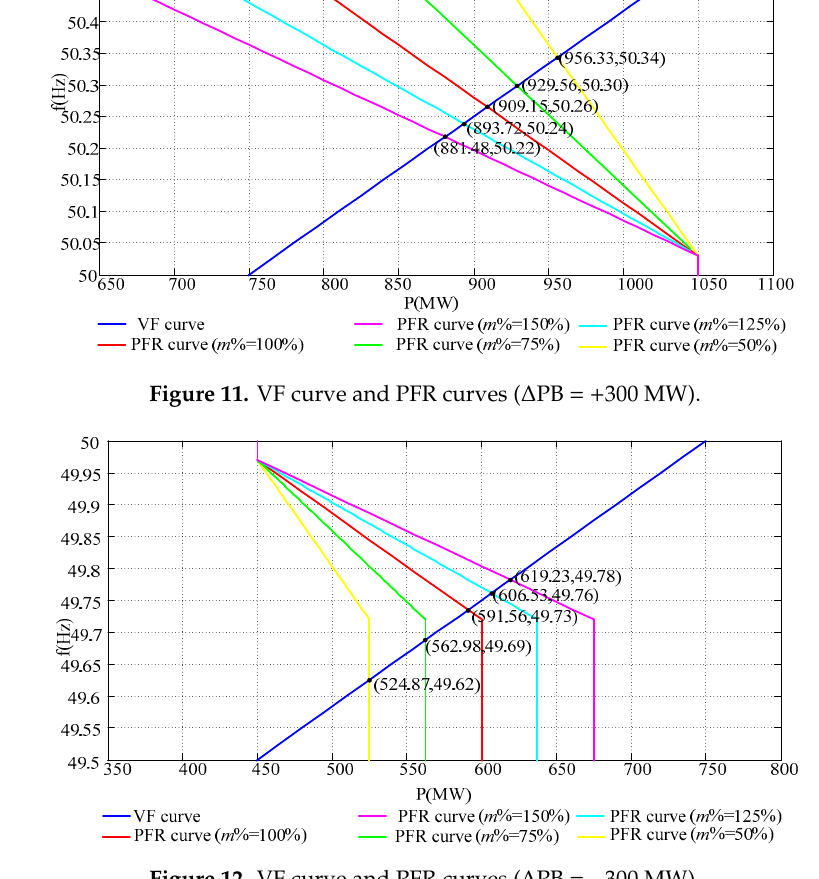
Figure 12. VF curve and PFR curves ( ∆ PB = − 300 MW). Table 6. The self-regulation proportions of power fluctuations (di ff erent